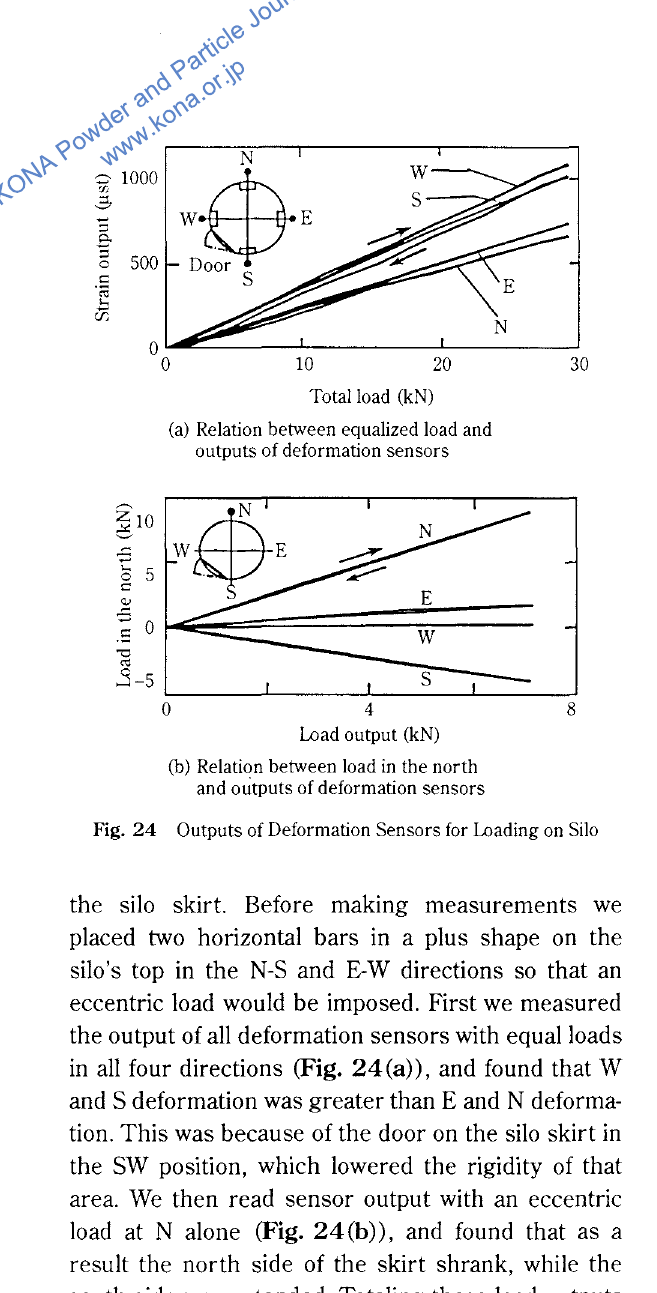
south side was extended. Totaling these load outputs showed that they are equal to the eccentric load at N within